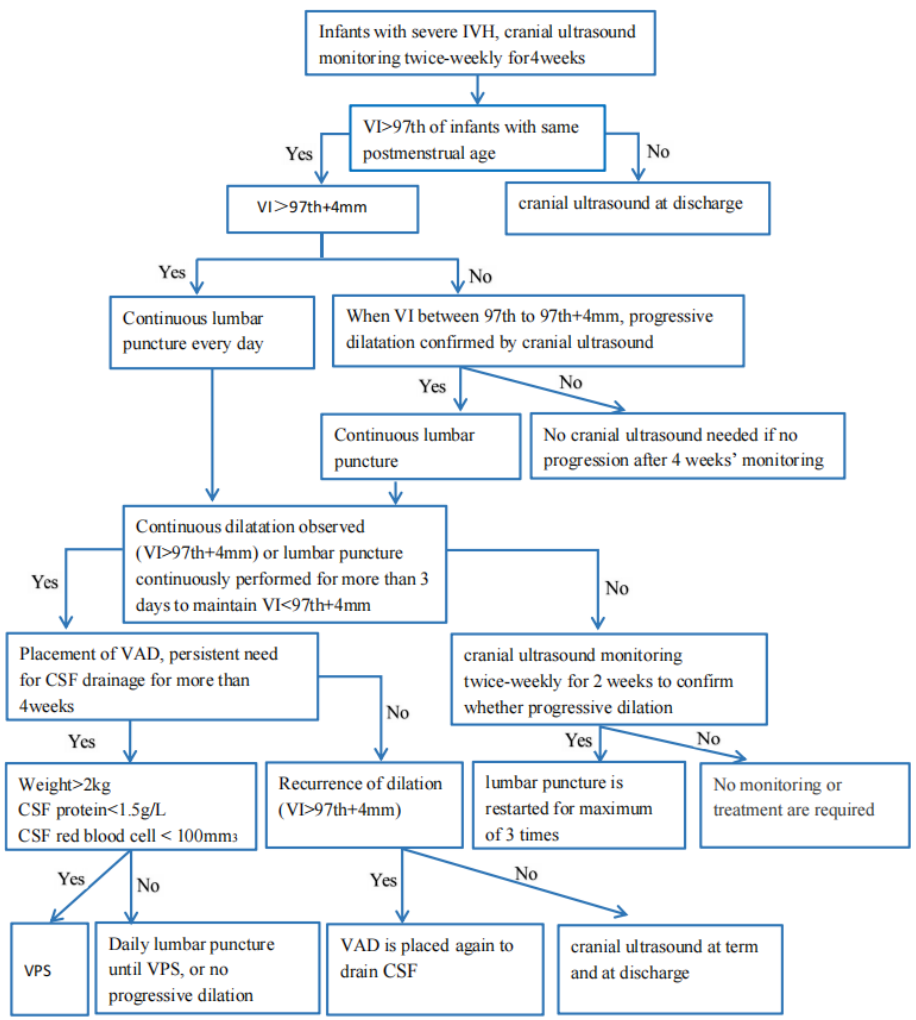
Figure 4. Flow diagram of monitoring and treatment of PHVD (IVH: intraventricular hemorrhage; VI: ventricular index; VAD: ventricular access device; CSF: cerebrospinal fluid; VPS: ventriculoperi- toneal shunt).